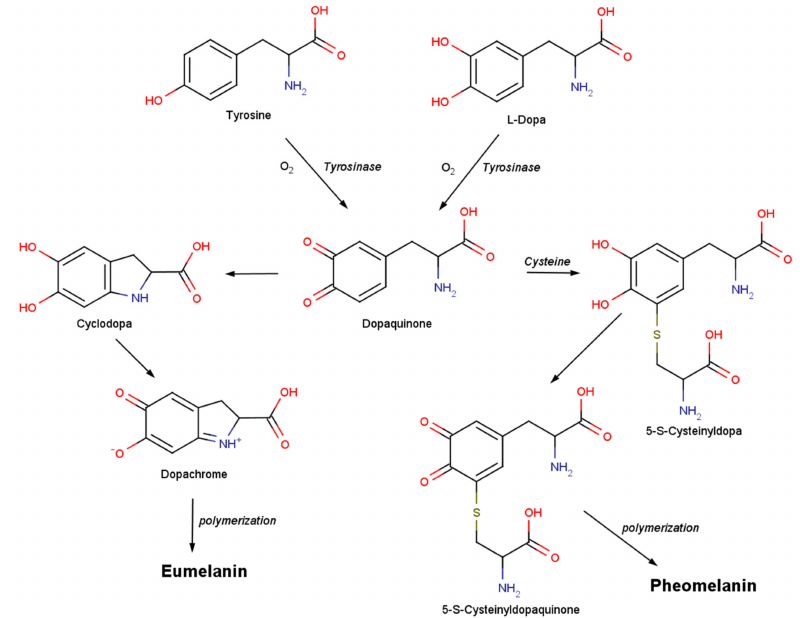
Figure 1. Scheme of eumelanin and pheomelanin synthesis.